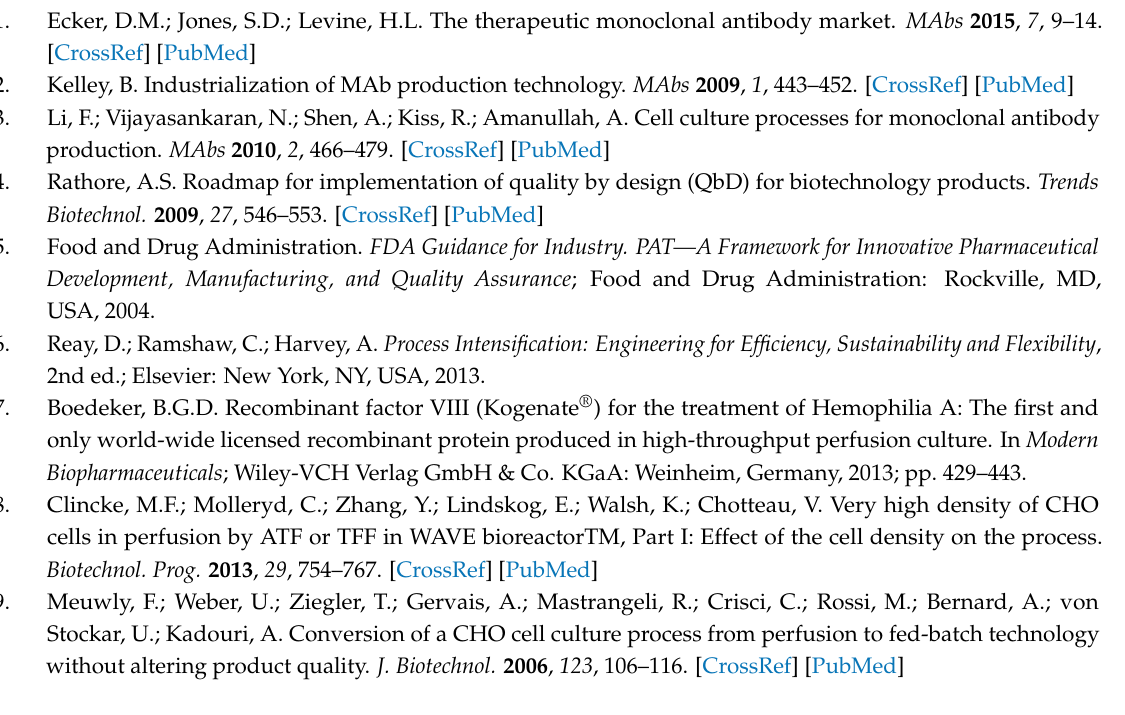
Table S1: Summary of the reactor set points and the corresponding measured values, Table S2: Glycan structures in glycosylation network, Figure S1: Process measurements of Experiment A, Figure S2: Process measurements of Experiment B, Figure S3: Process measurements of Experiment C, Figure S4: Process measurements of Experiment D, Figure S5: Secretion flux fitting of other IgG glycoforms, Figure S6: Residuals of random forest